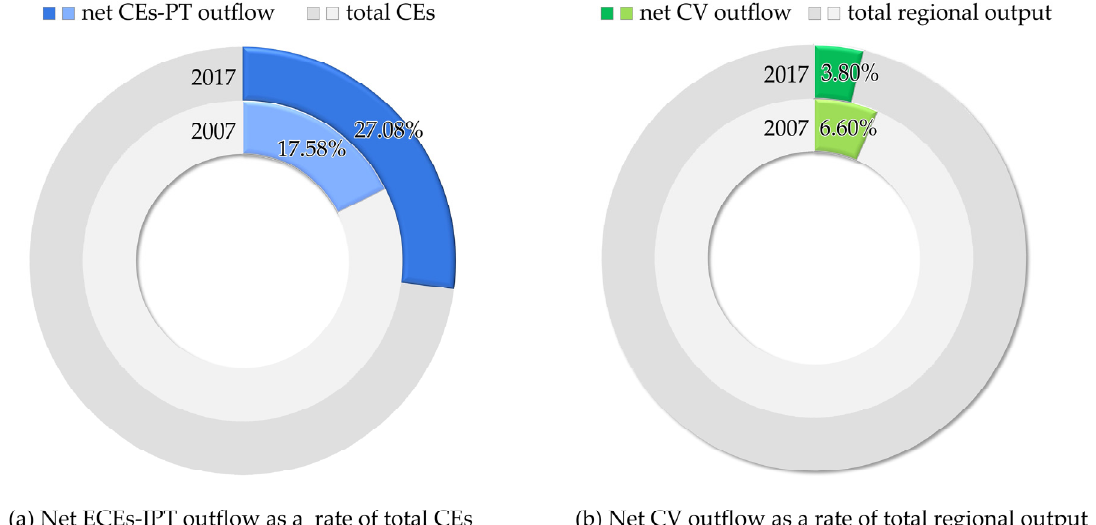
Figure 5. Net ECEs-IPT outflow as a rate of total CEs ( a ) and net CV outflow as a rate of total regional output ( b ) in Anhui among the YREB from 2007 to 2017.